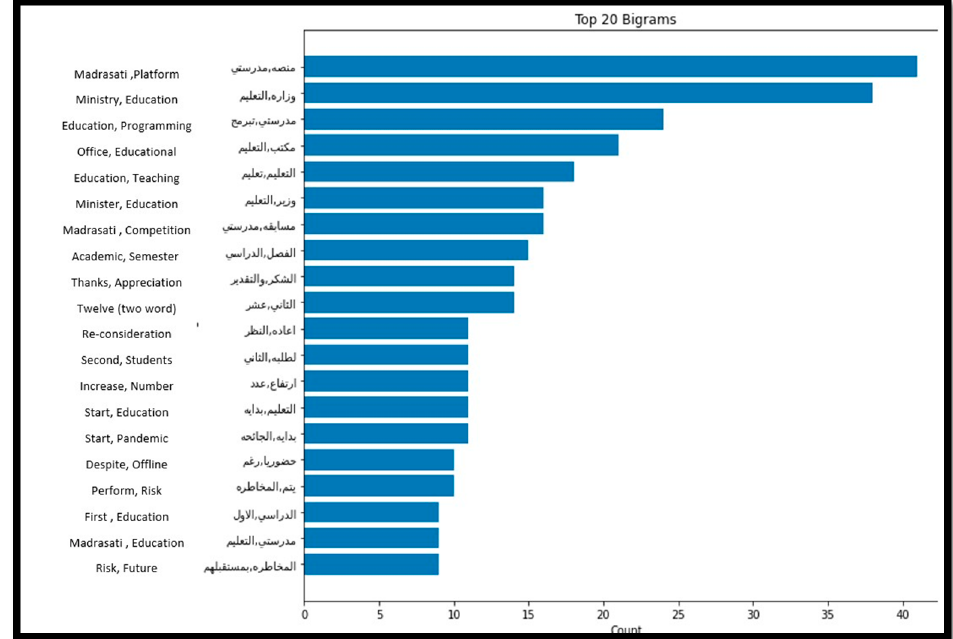
Figure 10. Top 20 Frequent words from the intermediate and high schools’ positive tweets.